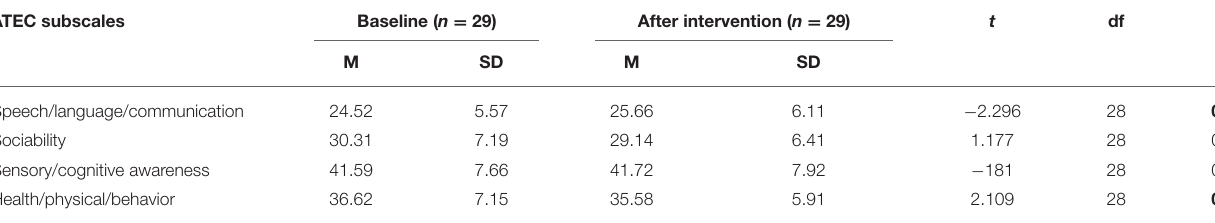
TABLE 4 | Scores of children with developmental disabilities on ATEC at the beginning and the end of the CST pilot program. ATEC subscales Baseline ( n = 29) After intervention ( n =